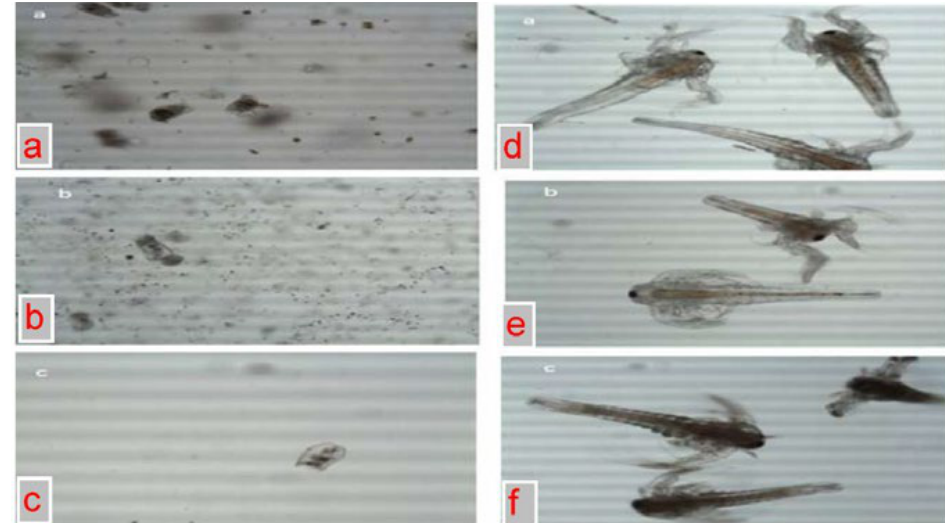
Fig. 9: (a) Rotifer before exposed to wastewater, (b) after exposed to treated wastewater, (c) after exposed to untreated industrial wastewater, and (d) Artemia before exposed to wastewater, (e) after exposed to treated wastewater and (f) after exposed to untreated industrial wastewater.